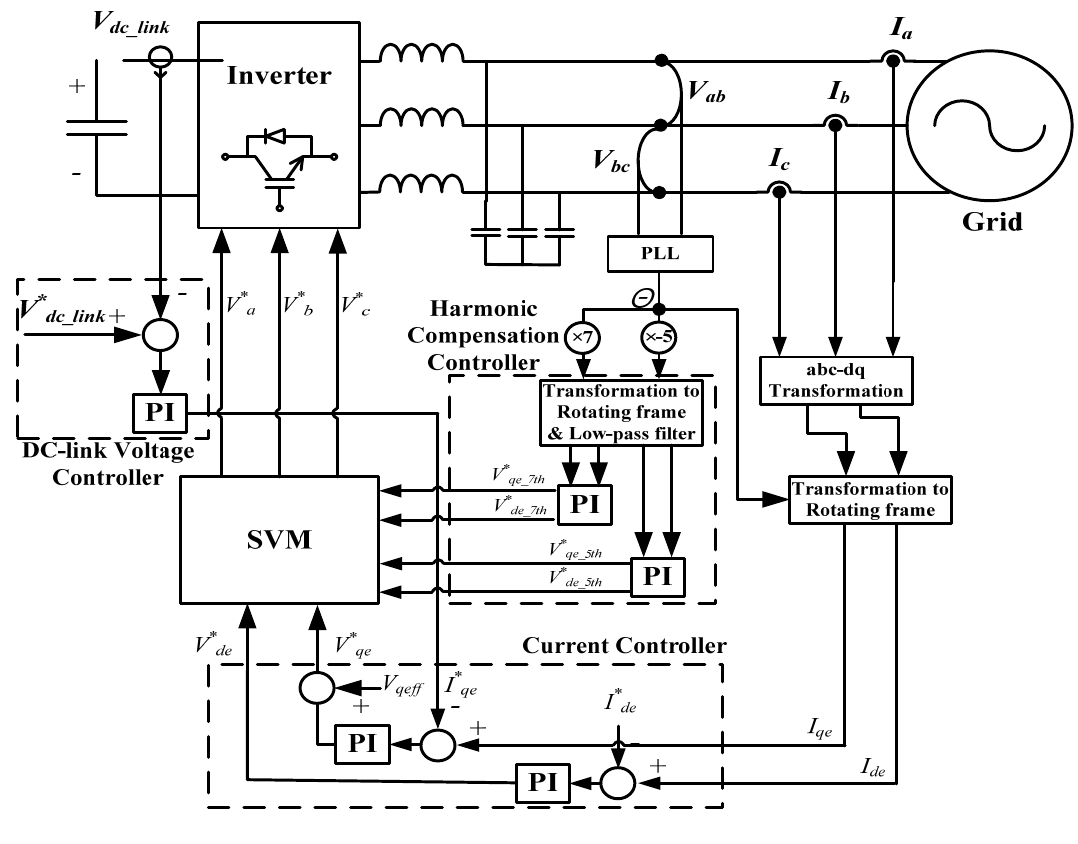
Figure 6. The total block diagram of the